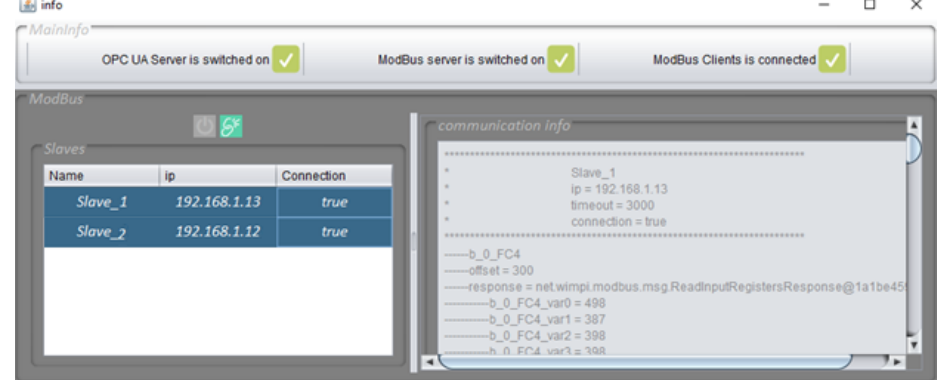
Figure 7. A screenshot of the graphic program in Java deployed on the OPC UA server for this work that shows a panel with the configuration of two PLC